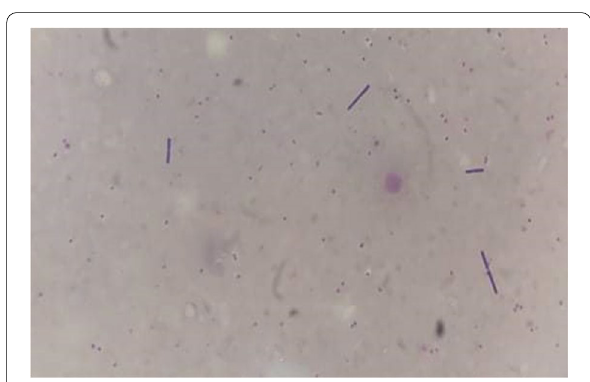
Fig. 1 Thick blood smear showing numerous Plasmodium falciparum . Giemsa, 100 ×